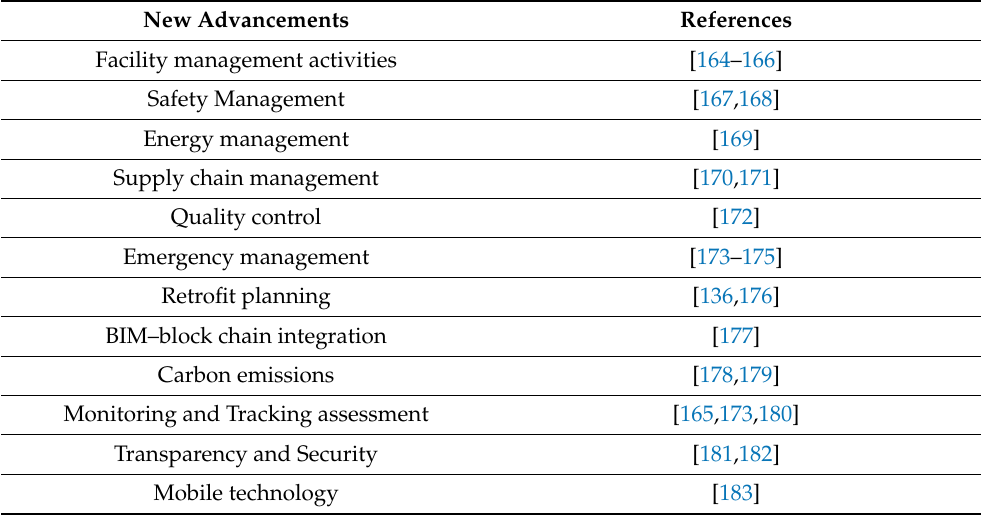
Table 4. Summary of new advancements towards